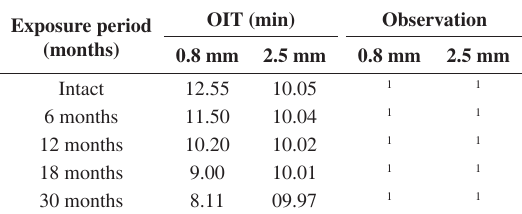
Table 3. Results of OIT tests after weathering exposure.